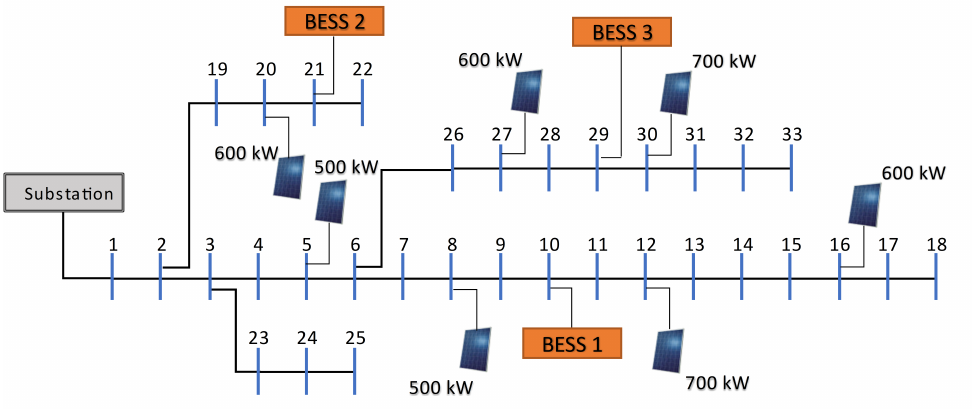
Figure 2. The 33-bus test system with 3 BESSs and 7 PV